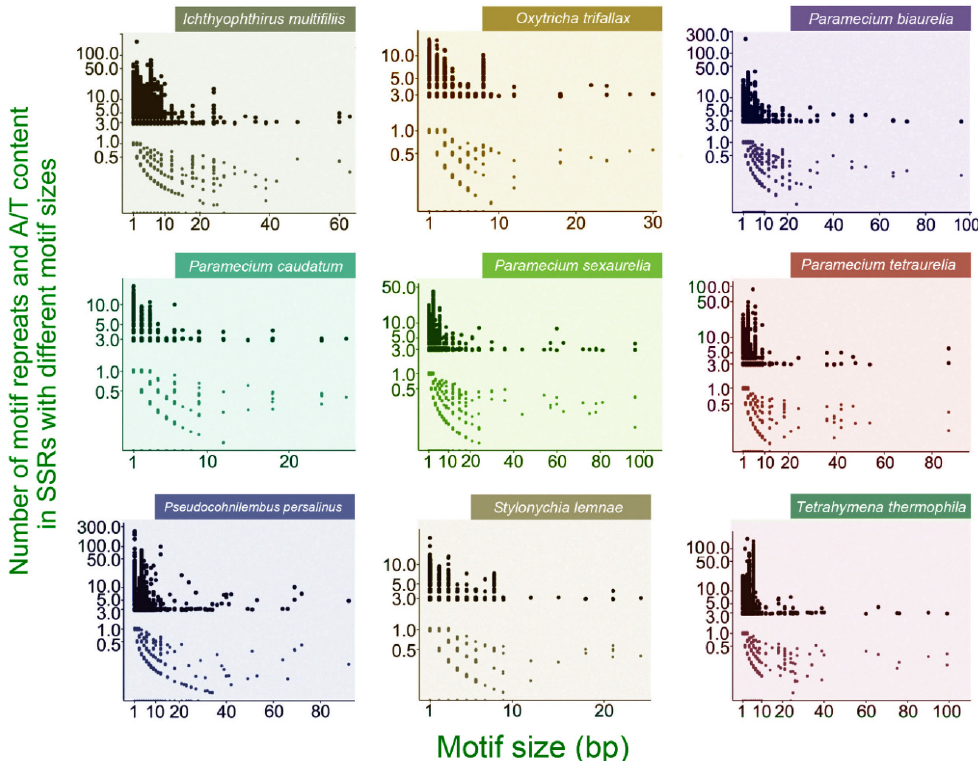
Figure 2. Number of motif repeats, which is represented by y-axis values ≥ 3, and A/T content in SSRs with different sizes of motifs, represented by y-axis values ≤ 1. Dots are jittered. Due to the limited jittering-distance, the sizes of dots do not reflect the dominating number of homopolymer SSRs. The y-axis is log10 transformed. The A/T content of SSRs is significantly higher than that of the corresponding genomes (one-sided paired t -test, t = -21.563, df = 8, p = 1.13 × 10 − 8 ; Tables 1, 2) and they are strongly correlated ( r = 0.90, p = 0.0008). The higher A/T content of SSRs is likely due to the dominance of A/T